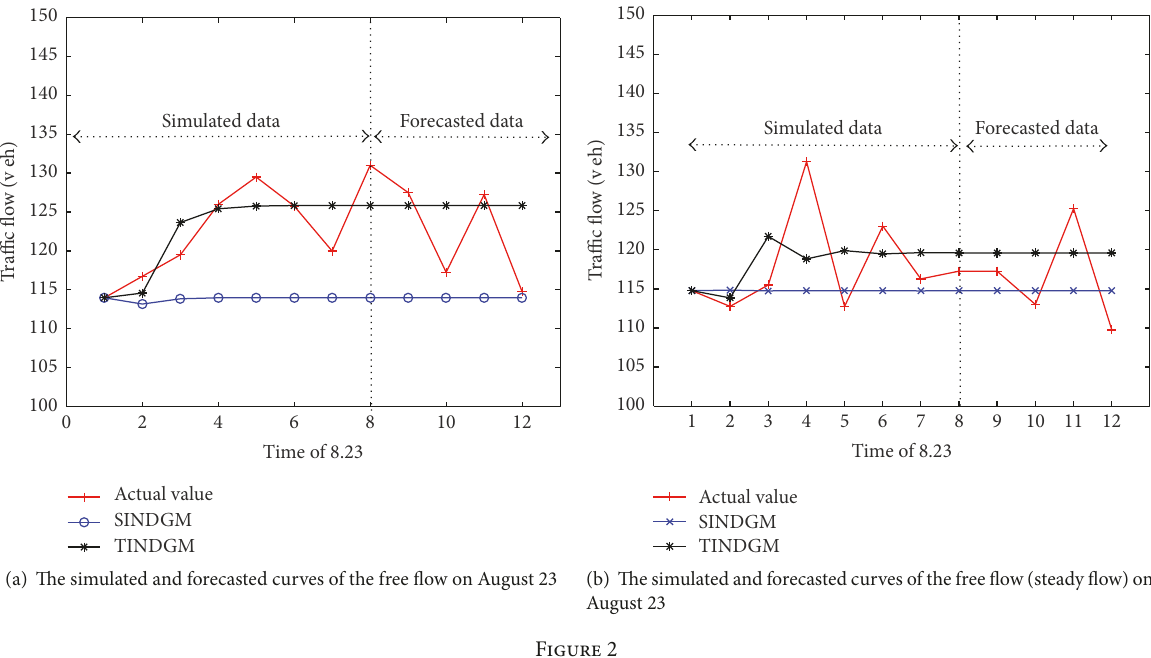
Table 3: Comparison of simulative and predictive results between the SINDGM and TINDGM for August 28. Serial